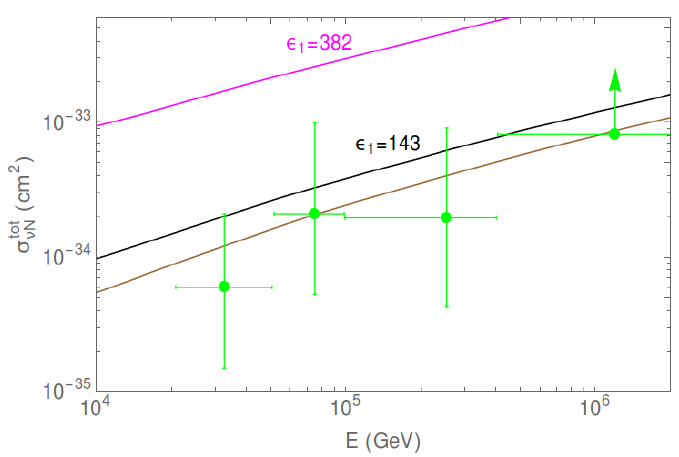
Figure 3 . Constraints on NSI described by eq. (4.3) in presence of a Z 0 of mass 5 GeV. Colour coding is the same as in (cid:12)gure 1.